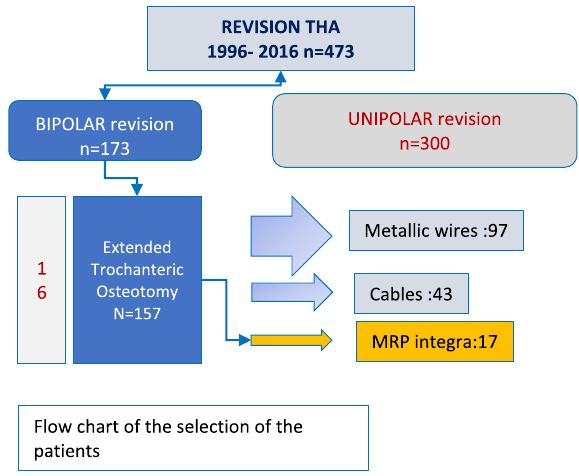
Figure 4. Flow chart of the selection of the patients.